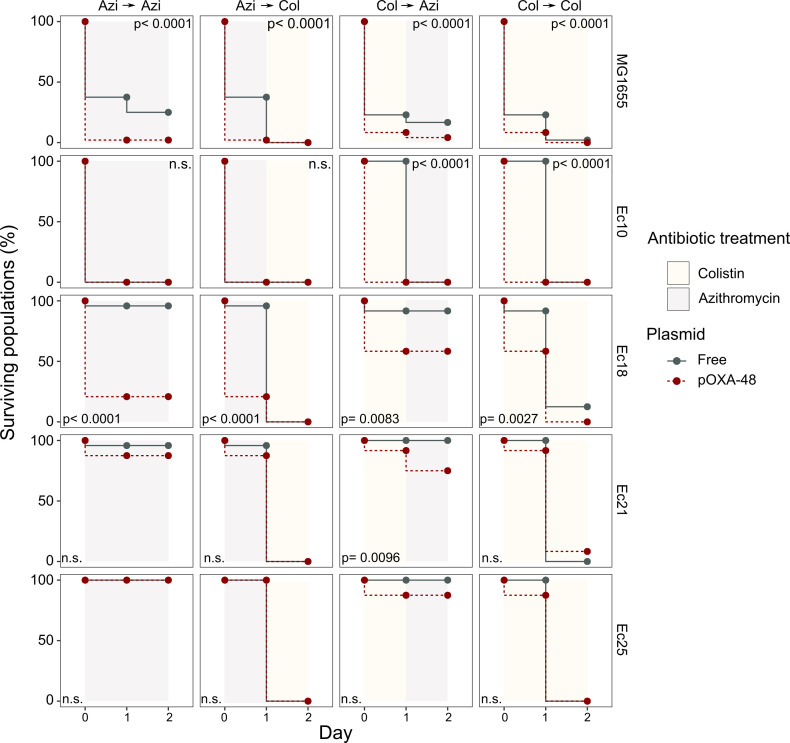
Plasmid-mediated CS can be exploited to preferentially kill plasmid-carrying bacteria.Survival curves of plasmid-free (gray solid lines) and plasmid-carrying (red dashed lines) bacterial populations in response to constant or sequential antibiotic treatments. Plasmid-free or plasmid-carrying bacterial populations were cultured separately for 2 days with either constant antibiotic exposure or with a change of antibiotic after the first day; treatments are specified by the background colors in each panel. Log-rank test p-values assessing statistically different survival curves are shown. n.s. non-significant. For strains Ec10, Ec18, Ec21, and Ec25 n = 24; for MG1665 n = 48. AZI, azithromycin; COL, colistin.
Figure 3—source data 1.Numerical data that are represented in Figure 3.